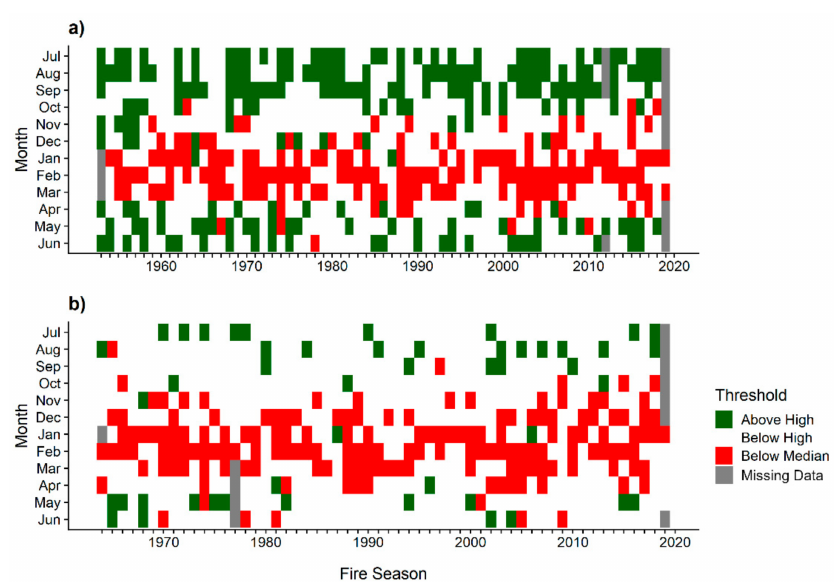
Figure 7. Monthly river flow classified as above and below high and median thresholds for forest fire risk identified for this analysis for the ( a ) Franklin River and ( b ) Davey River based on respective historical river flow records.